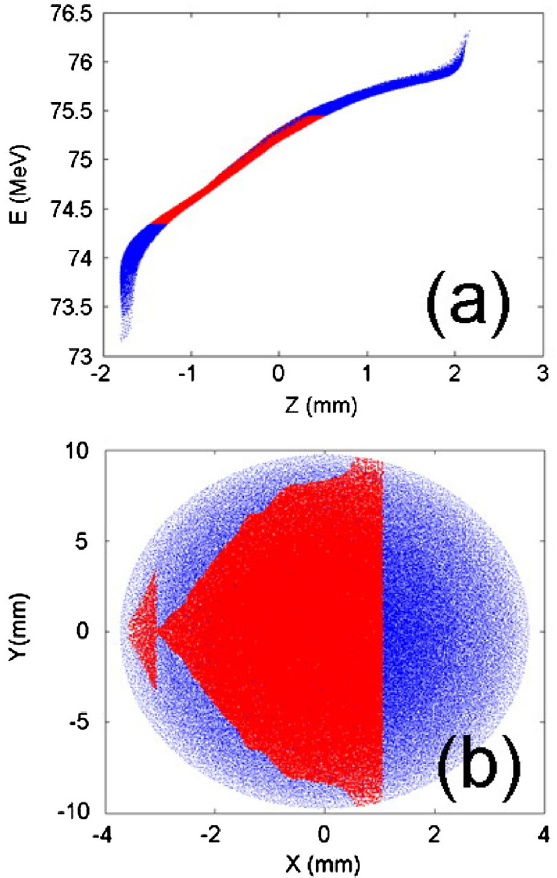
FIG. 4. (a) Longitudinal phase space of the beam after a chicane and energy chopper (red ones remain). (b) Transverse shape of the beam after the transverse mask (red ones remain).